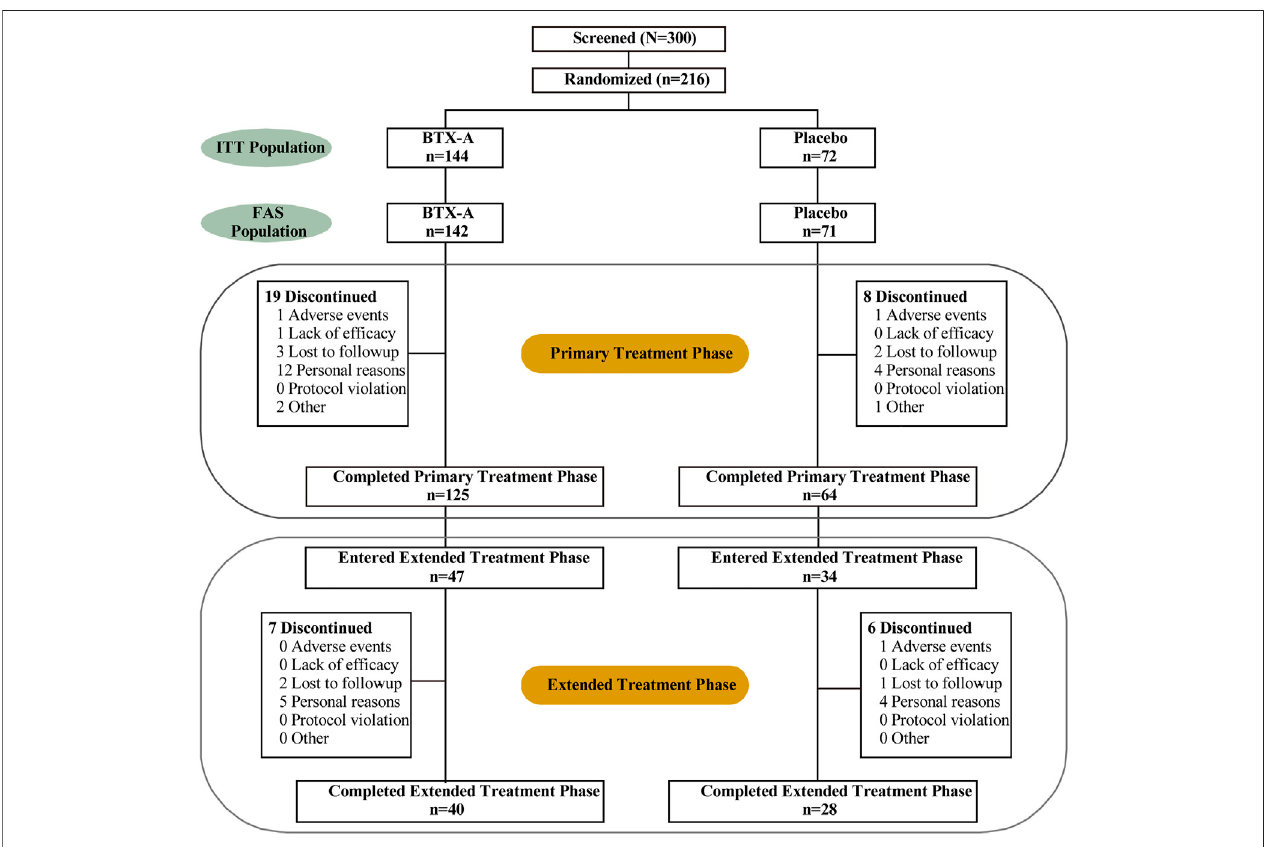
FIGURE 1 | Patient disposition and fl ow. ITT = intention to treat; FAS = full analysis set.